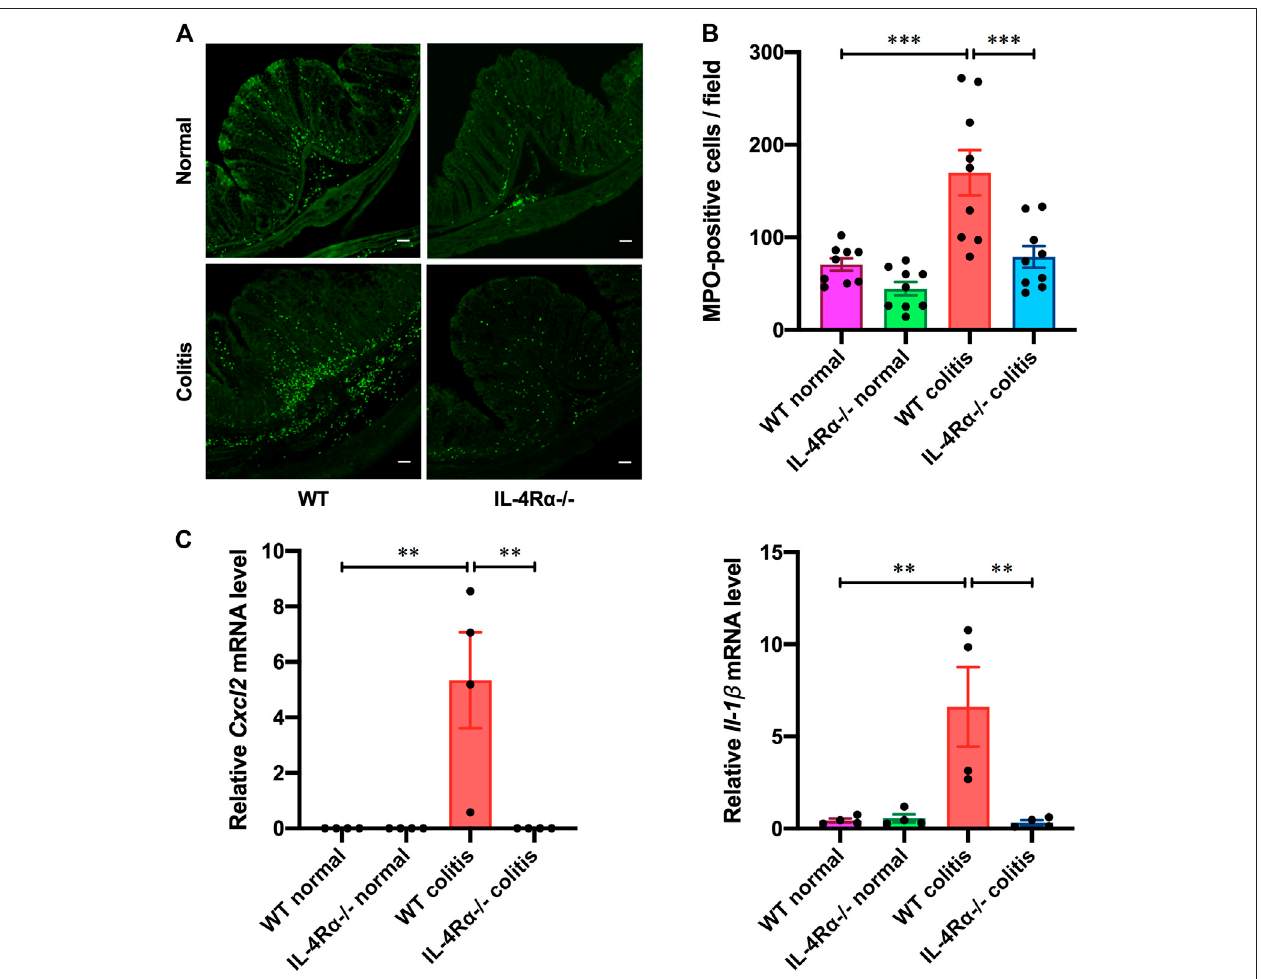
FIGURE 3 | IL-4R α -/- mice exhibit a low in fl ammatory response to DSS-induced colitis. Colitis was induced in WT and IL-4R α -/- mice by daily treatment with 3% DSS solution in the drinking water for seven days. (A) Confocal micrographs of the colonic mucosa of colitis mice show staining of MPO-positive cells. The scale bar represents50 µm. (B) ThenumberofMPO-positivecellsinthecolonicmucosaisshown.Thedataarepresentedasthemean ± SEMvaluesforninemucosaefromthree mice. *** p < 0.001. (C) DSS-induced changes in the mRNA expression level of Cxcl 2 and Il-1 β in the colons of WT and IL-4R α -/- mice. The data are presented as the mean ± SEM values for four mice and are representative of one of two independent experiments. * p < 0.05; ** p < 0.01.